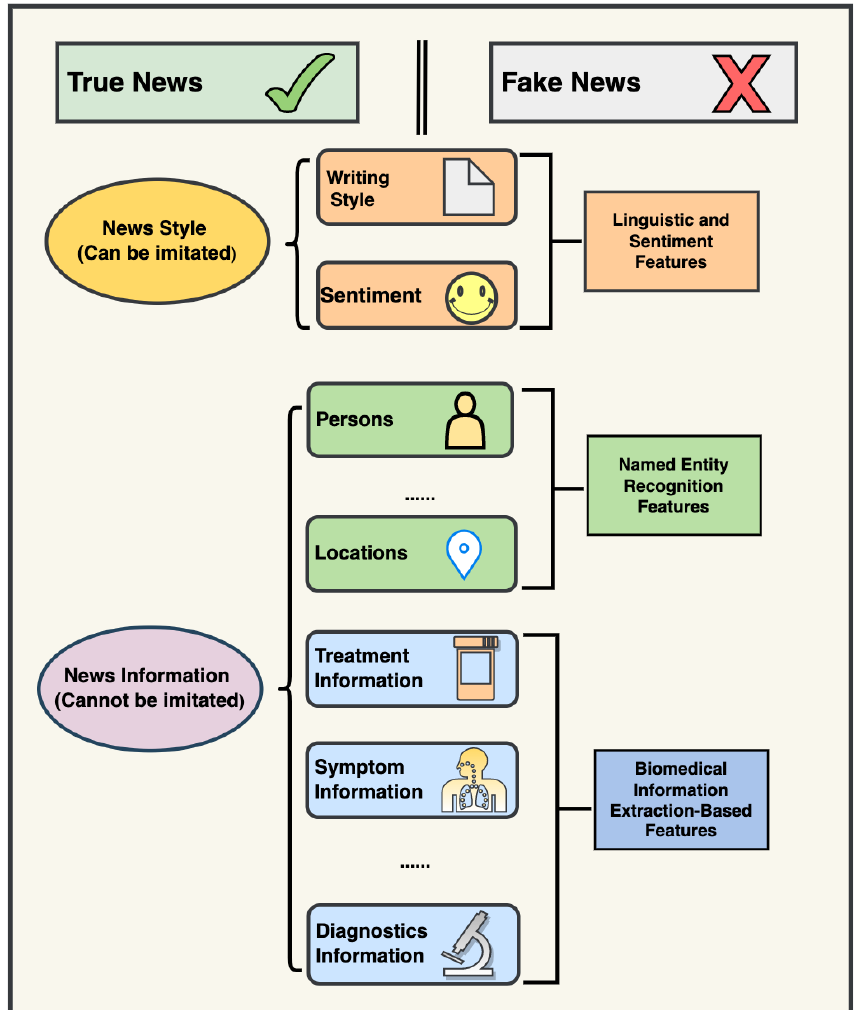
Figure 1. Machine learning features for COVID-19 news detection and the contents of news articles modeled by the features.